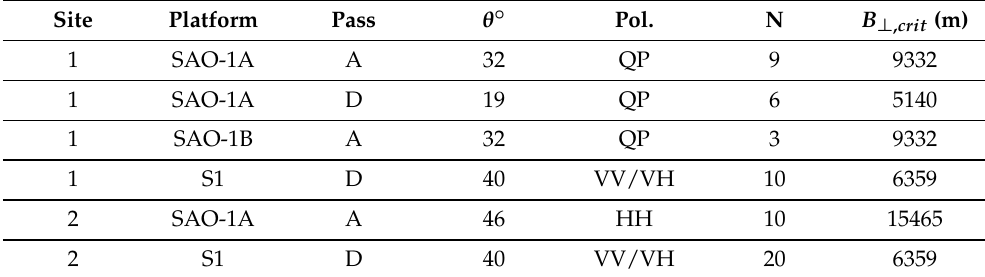
Table 1. Temporal SAR datasets. Site 1 is Corrientes, Site 2 is Neuquén.